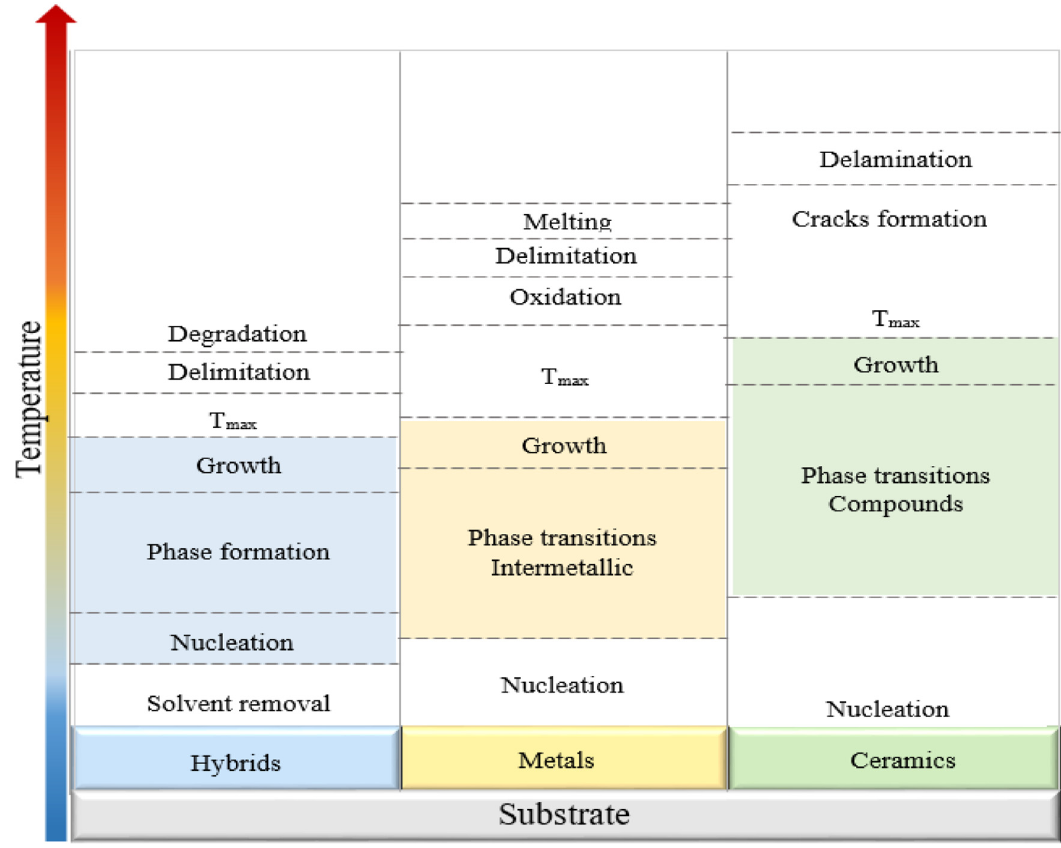
Fig. 1. Main processes during thermal assessment of coatings made of different types of